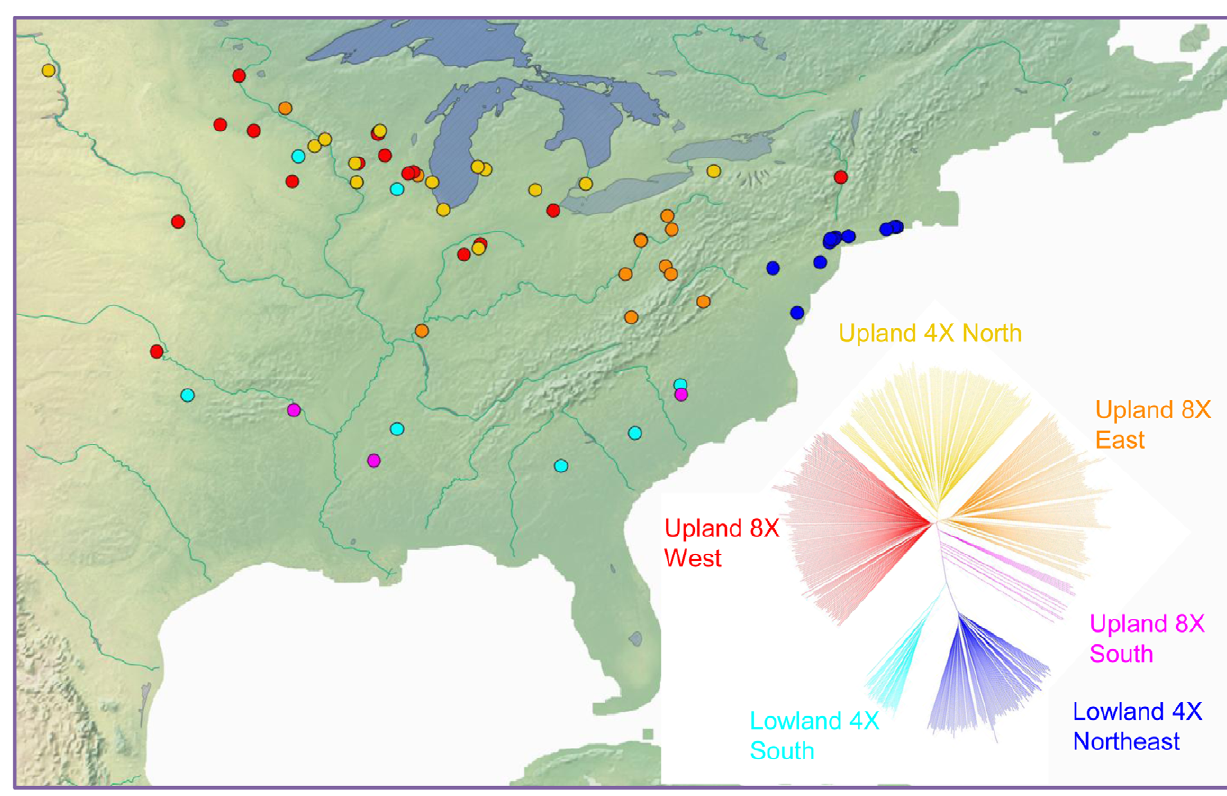
Figure 6. Geographic distribution and phylogenetic groups of switchgrass in the association panel. Each population is indicated by a dot on the map in its approximate source location and a branch in the phylogenetic tree of the same color. Clades are labeled with ecotype, ploidy and geographical descriptors.